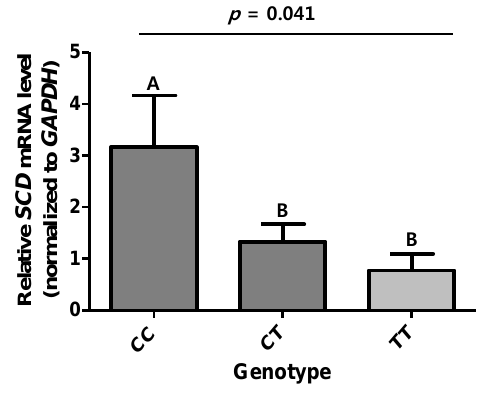
Figure 2. Relative mRNA levels of porcine SCD in the longissimus dorsi muscle of Berkshire pigs according to genotypes of c.*2041T>C SNP. The SCD mRNA levels were normalised to those of GAPDH . All values are expressed as mean ±standard error of three independent experiments. A and B indicate significantly different groups, as determined by ANOVA (p = 0.041). SCD , stearoyl-CoA desaturase; SNP, single nucleotide polymorphism; GAPDH , glyceraldehyde-3-phosphate dehydrogenase; ANOVA, analysis of